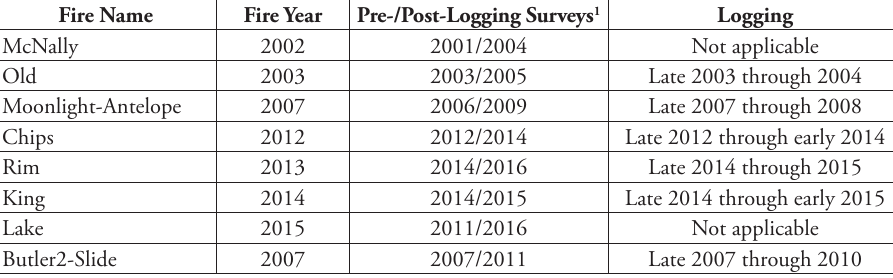
Table 1. Years in which the fires, pre-logging and post-logging surveys and logging occurred in each of the fires in this